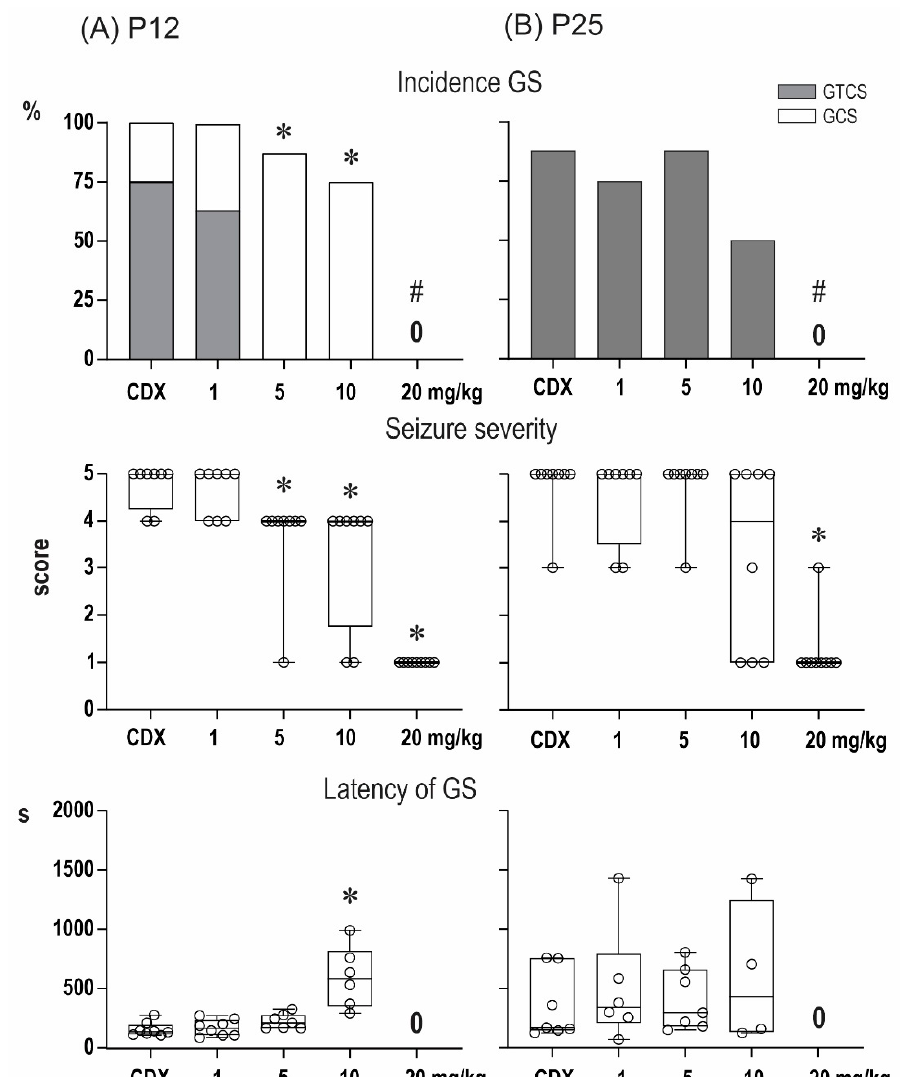
Figure 3. Effect of pregnanolone glutamate (PA-G) on seizures induced by pentylenetetrazol in 12- ( A ) and 25-day-old rats ( B ). From top to bottom: the incidence of generalized seizures (GS) is shown in columns (the black parts indicate complete generalized tonic-clonic seizures; the white parts show generalized clonic seizures without the tonic phase). The severity of seizures is expressed as a score [20], and the latencies of generalized seizures are shown as box plots (min to max) with individual values (circles). # denotes a significant difference in the incidence of GS compared with the controls, * denotes a significant difference in the incidence of TF in seizure severity and GS latency compared with the controls, and 0 means that none of the rats in the group exhibited